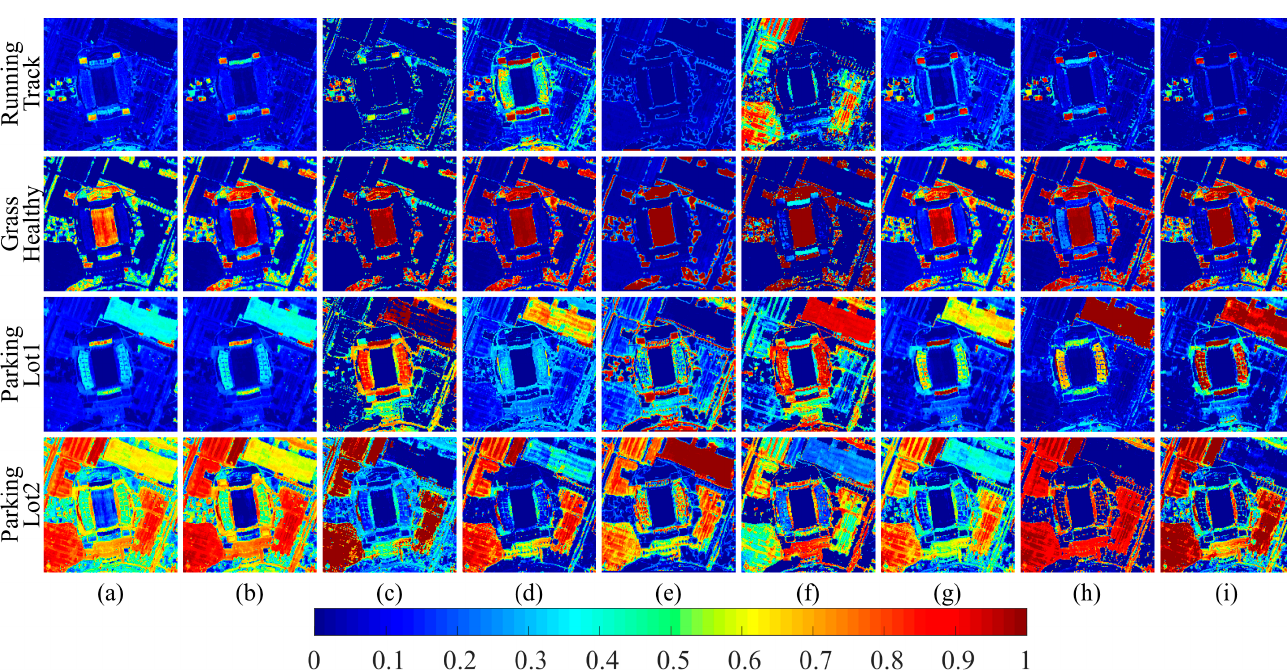
Figure 15. Visualization results of the abundances of Houston data. ( a ) VCA-FCLS. ( b ) SGCNMF. ( c ) DAEU. ( d ) MTAEU. ( e ) CNNAEU. ( f ) CyCU-Net. ( g ) MiSiCNet. ( h ) SSANet. ( i )